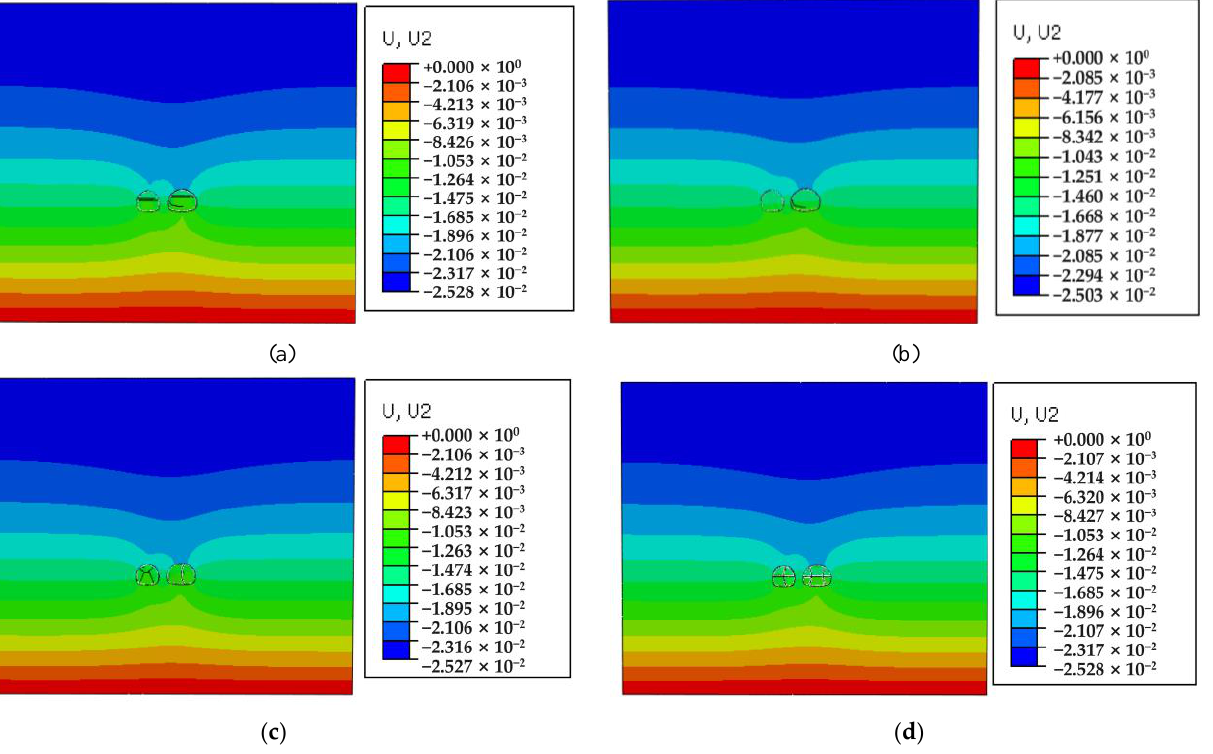
Figure 5. Overall vertical displacement of surrounding rock (unit: m): ( a ) Step method; ( b ) Full section method; ( c ) CD method; ( d ) Double wall heading method.